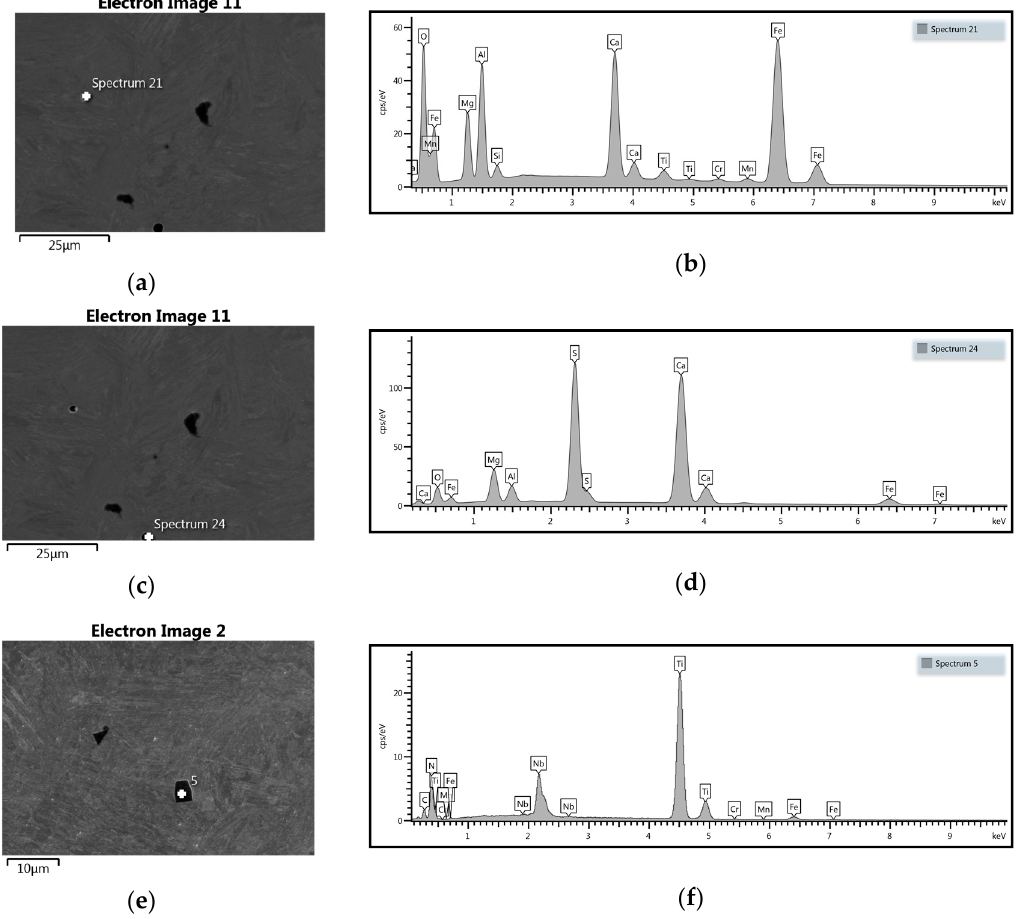
Figure 2. Large particles of inclusions and results of the energy dispersive X-ray spectroscopy (EDX) analysis of ( a , b ) oxides; ( c , d ) sulfides; ( e , f ) titanium nitrides enriched with Nb.